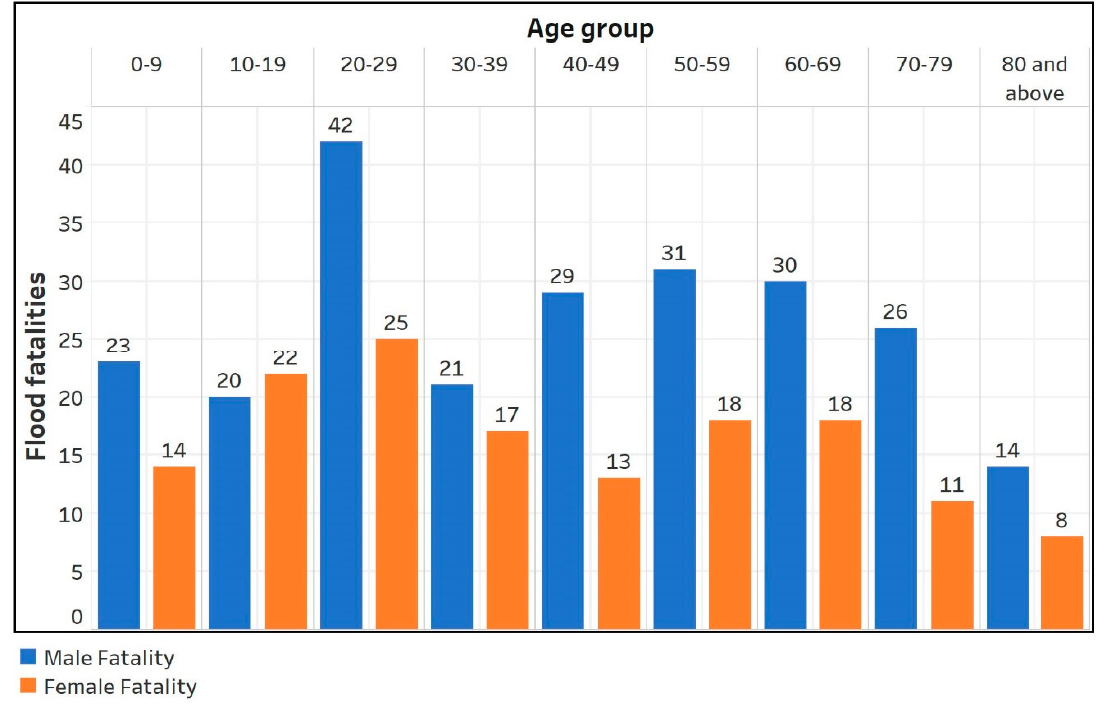
Figure 8. Numbers of vehicle-related flood fatalities in Texas, 1959–2019 by age and gender.